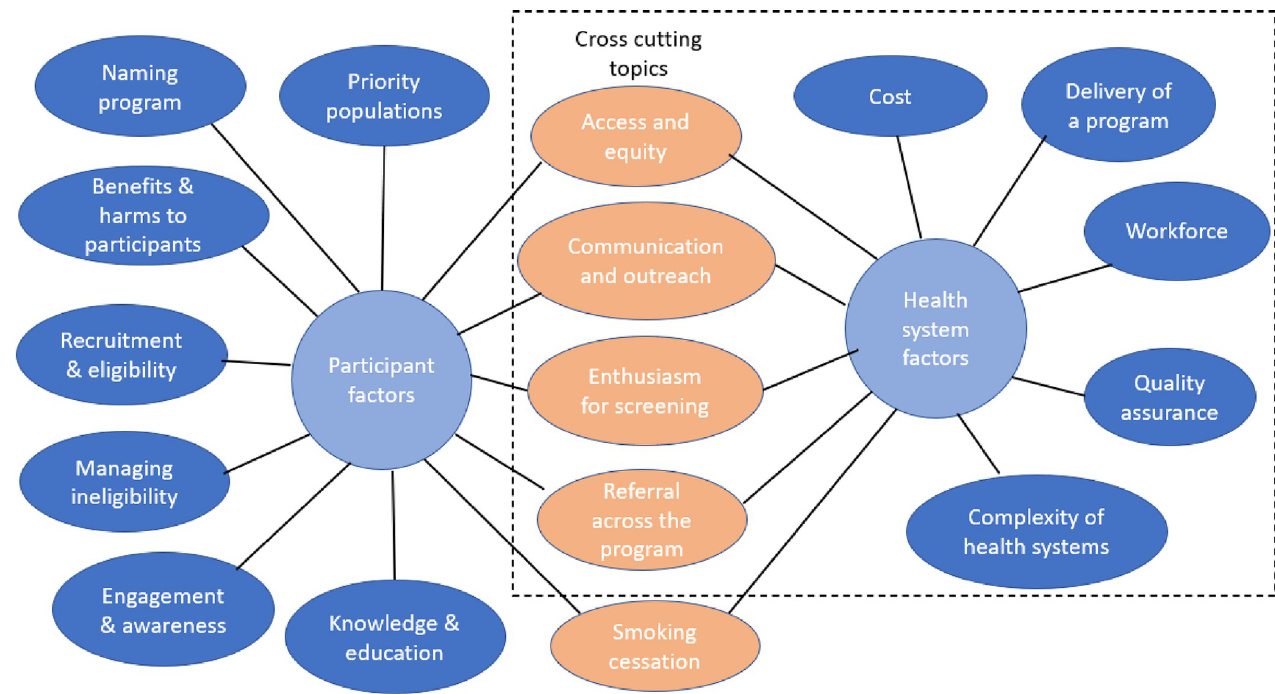
Fig 1. Participant and health system factors identified (in blue ovals) during analysis including cross-cutting topics (in orange ovals), with the dotted line indicating those topics included within this manuscript.